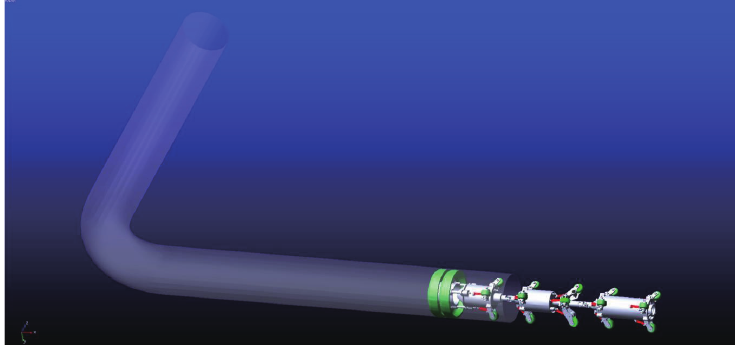
Figure 7. Virtual prototype model of the pipeline endoscope robot in